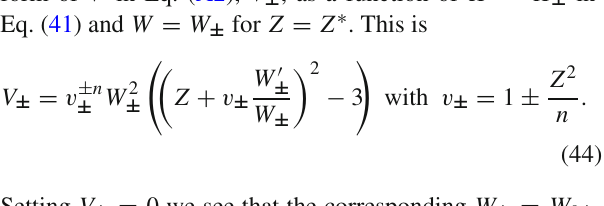
Fig. 2 The (dimensionless) SUGRA potential V 2f / m 2 m 2 as a function of z 1 and z 2 in Eq. (17) for ¯ z 1 = ¯ z 2 = 0 and the inputs shown in column B of Table 1. The location of the dS vacuum in Eq. (26b) is also depicted by a thick black point